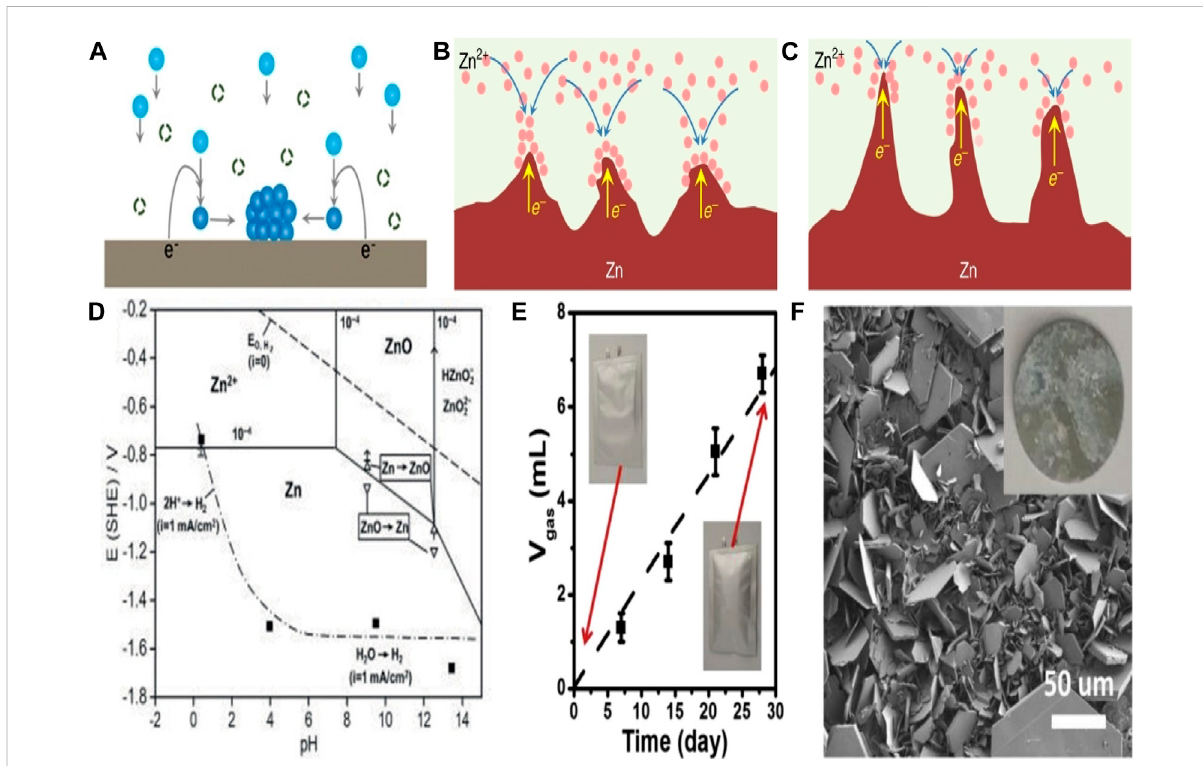
FIGURE 3 Schematic representation of the creation of Zn atomic clusters during unconstrained 2D Zn 2+ diffusion. (A) Schematic representation of the tip effectin (B) .Dendriteformationisoption (C) .Pourbaixdiagramofthe10 – 4 MZn 2+ systeminZn/H 2 O. (D) ThegasevolutionofaZnsymmetriccellina 3 M ZnSO 4 electrolyte at various resting times. (E) The Zn anode ’ s surface morphology after 30 days of immersion in 3 M ZnSO 4 electrolyte. (F) Reproduced under the terms of the CC-BY Creative Commons Attribution 4.0 International license (Zhang et al., 2022). Copyright (2022), Energy